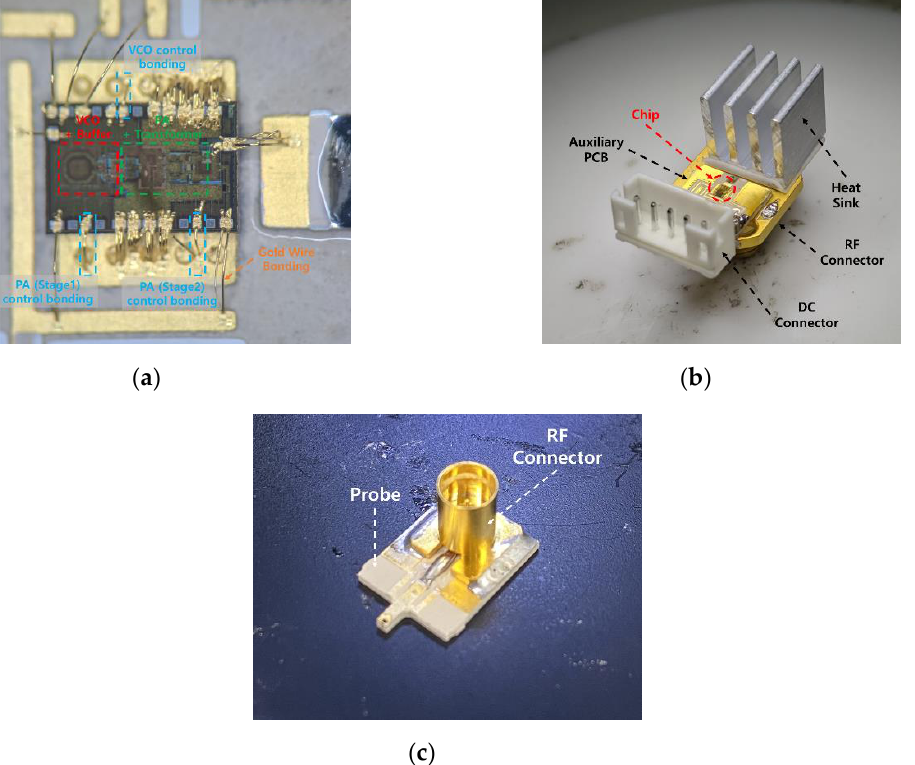
Figure 11. Photograph of the fabricated ( a ) chip, ( b ) auxiliary PCB with supplementary parts, and ( c ) probe.